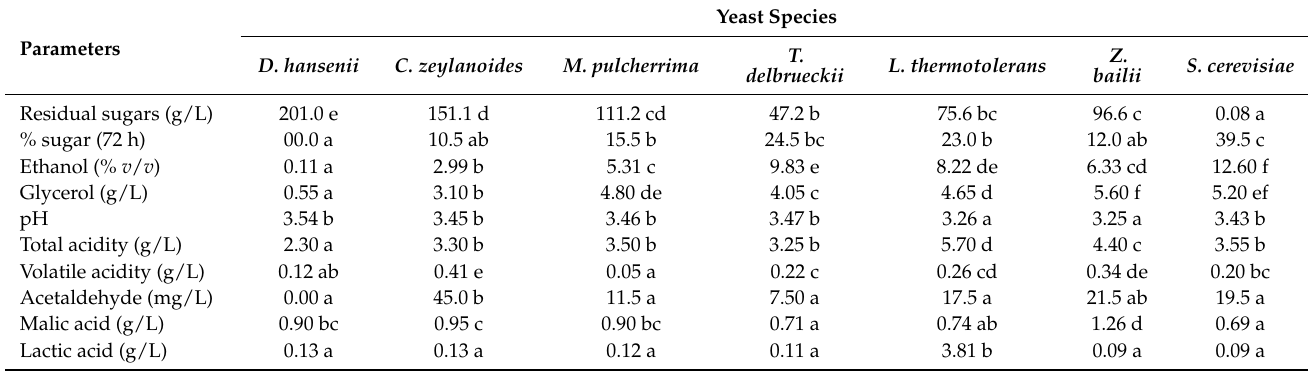
Table 3. Enological traits of wines fermented by different non- Saccharomyces yeast species and statistical analysis [58].